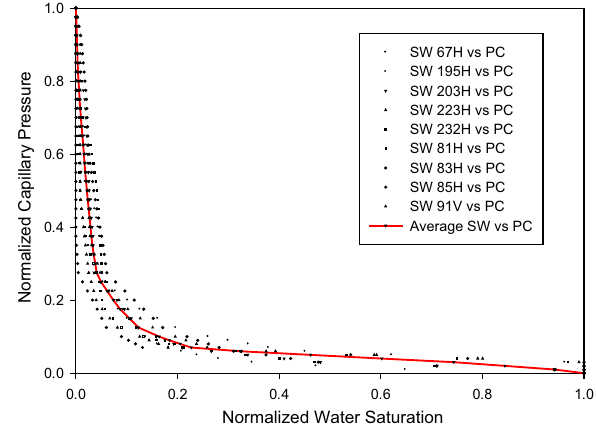
Fig. 5 Normalized capillary pressure versus normalized water satura- tion for rock type 1. Sample showing the process of averaging nor- malized